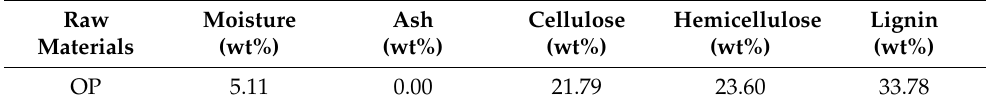
Table 3. Physico-chemical properties of OP.